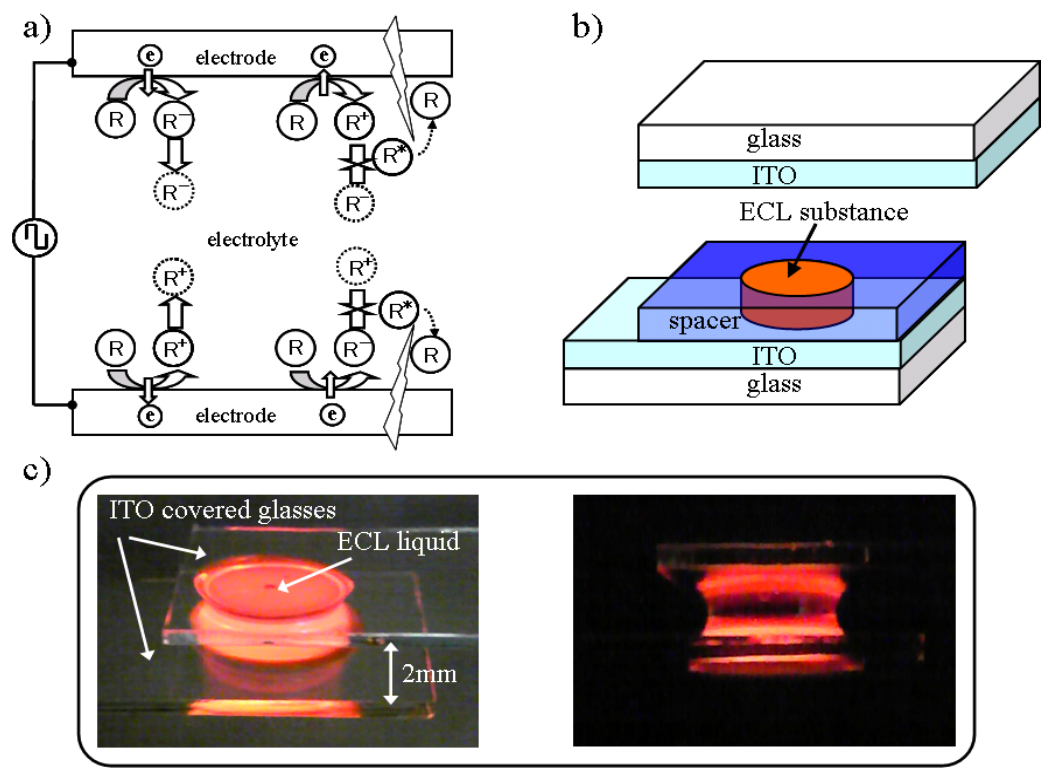
Figure 1. (a) Illustration of AC driven ECL mechanism. (b) Schematic illustration of ECL cell structure and fabrication. (c) Visible appearance of emission between ITOs from ECL liquid. Cross section of emitting ECL liquid